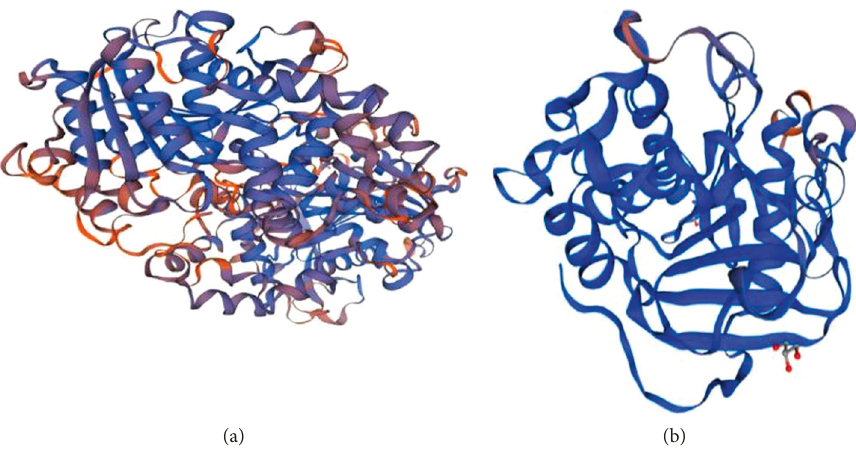
Figure 5: Lipase protein of (a) Malassezia furfur and (b) Malassezia restricta .